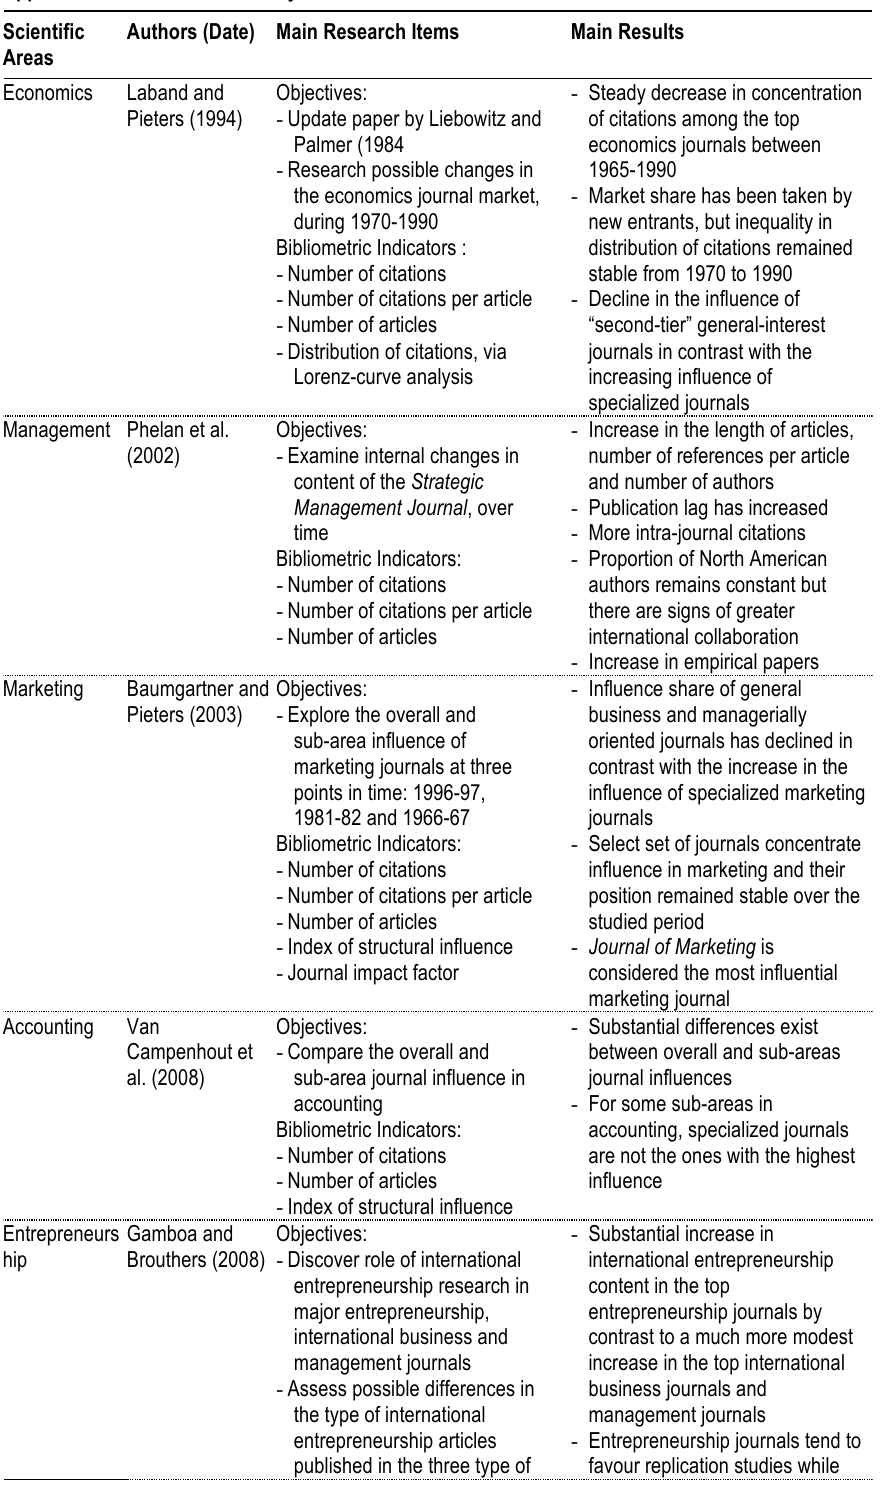
Table A1a: Bibliometric studies – Journal